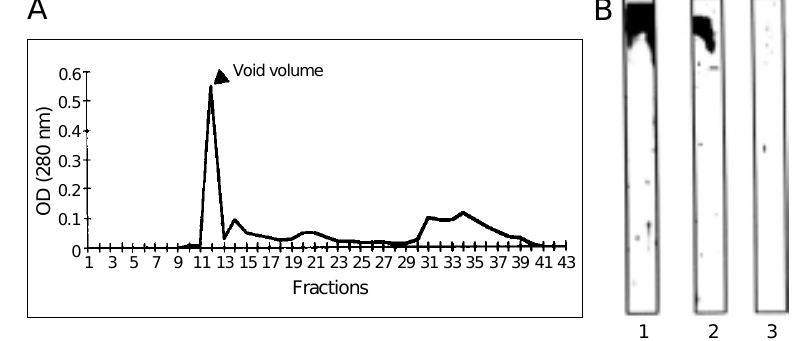
Figure 1 - Preparation of thyroglobulin. A , Gel filtration on Sephadex G-200 of an extract of human thyroid. Thyroglobulin was eluted in the void volume. B , SDS-PAGE of void volume effluent. Lane 1 , Silver-stained; lane 2 , detected with anti-thyroglobulin antibodies; lane 3 , not detected with anti-TPO